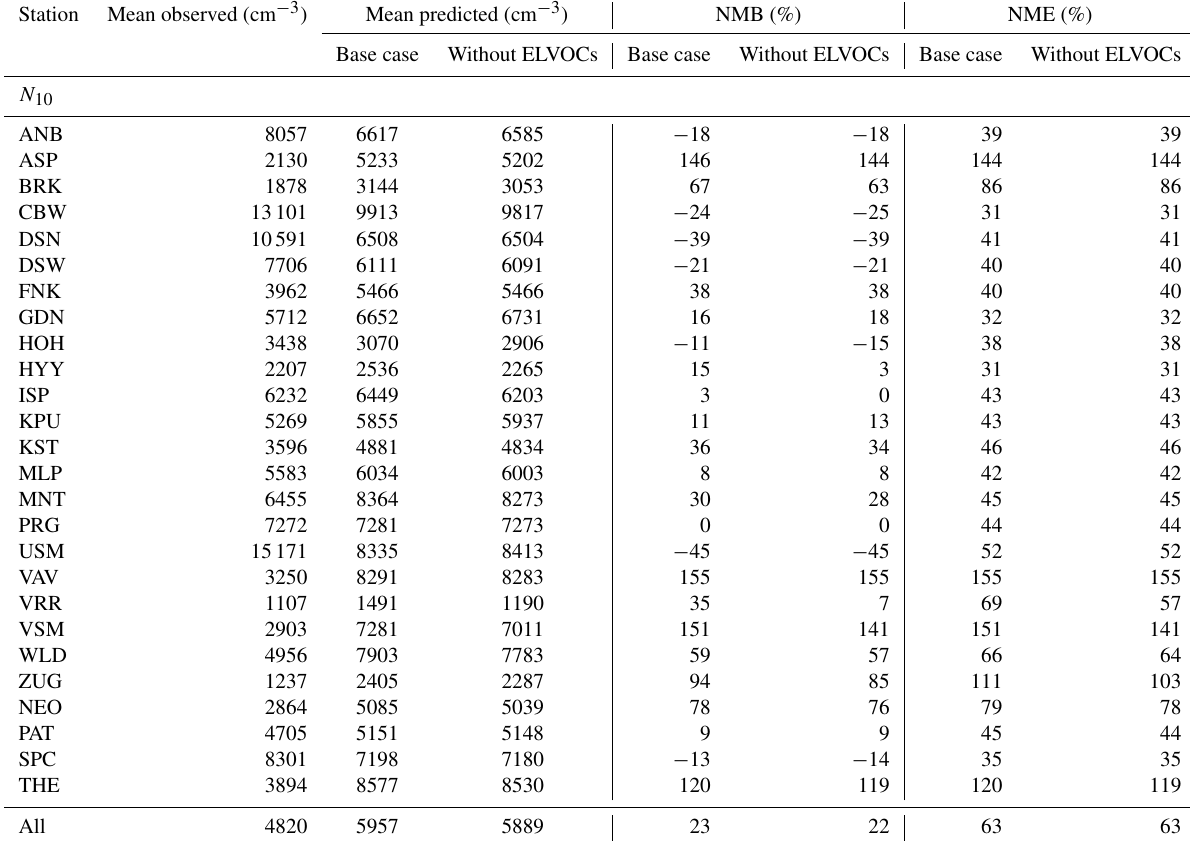
Table 2. Prediction skill metrics of PMCAMx-UF against daily ground measurements of particle number concentration above 10nm ( N 10 ) from 5 June–8 July